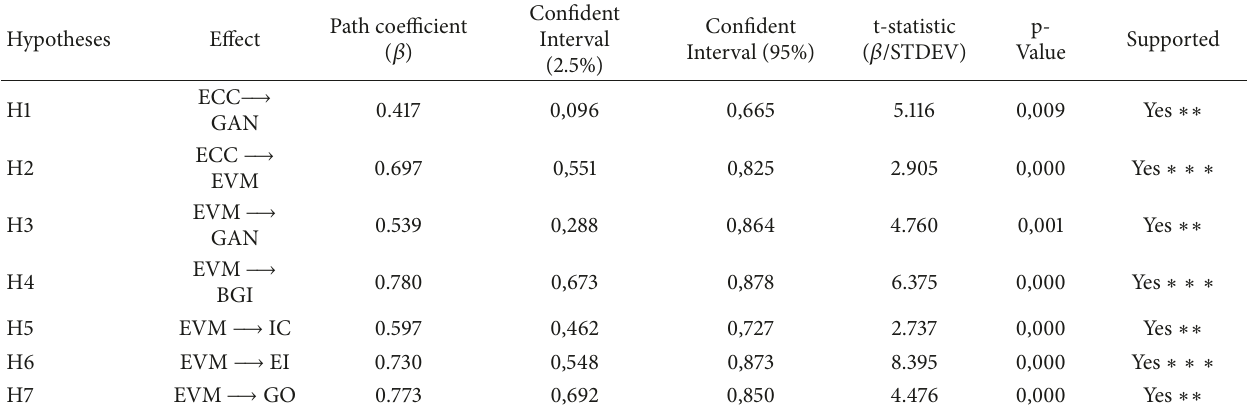
Table 5: Comparison of hypothesis.